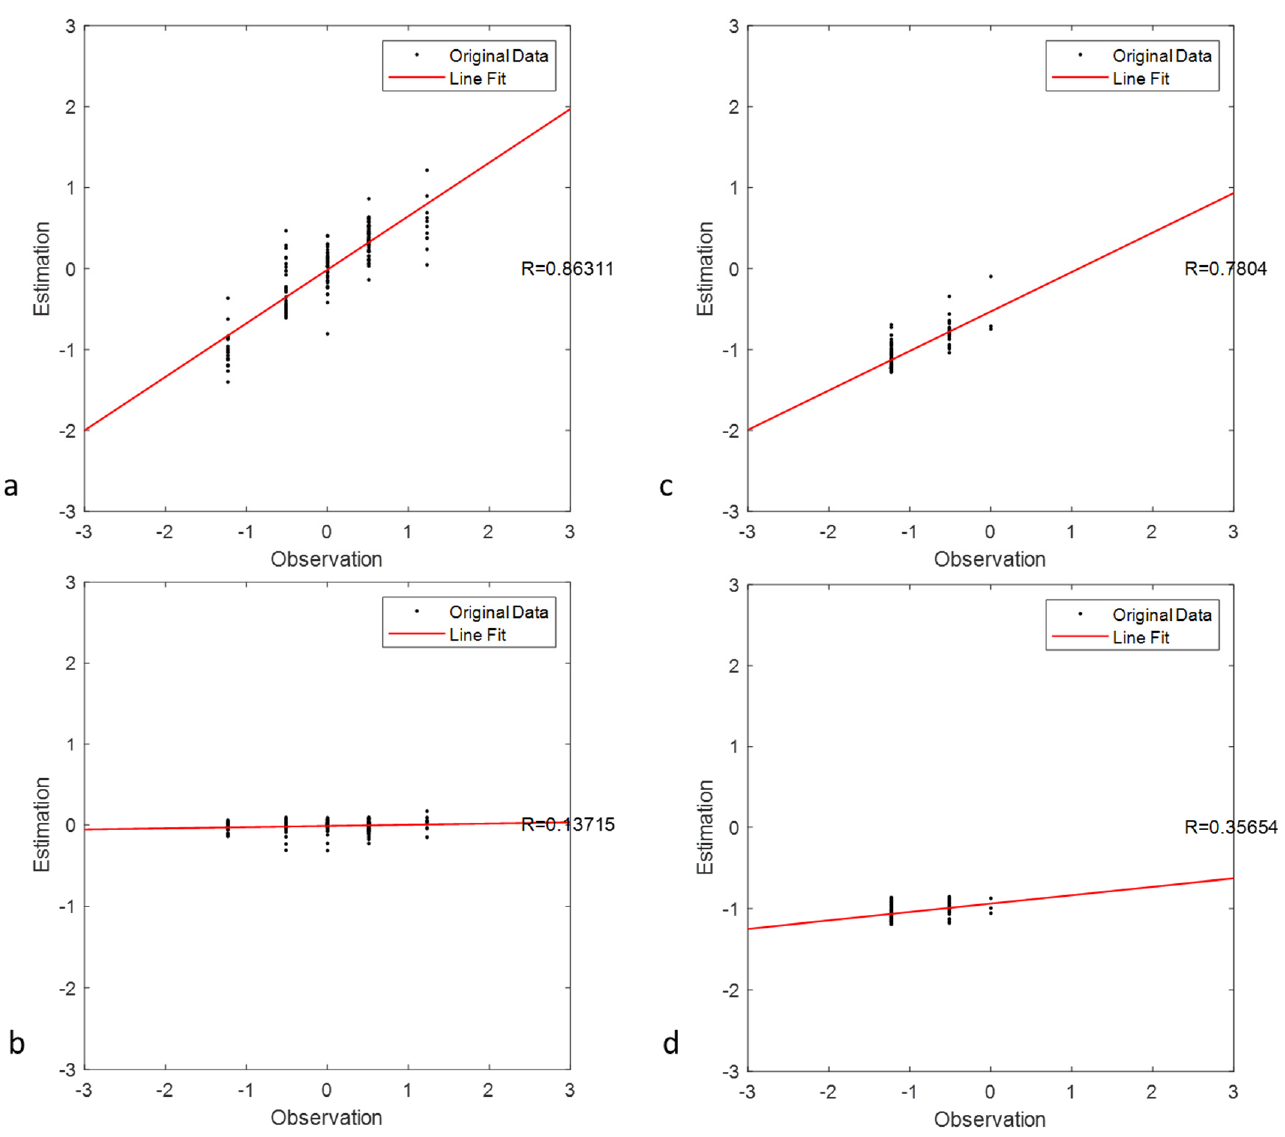
Figure 4. Estimation and observation plots of spatial ( a , c ) and nonspatial ( b , d ) downscaling of SPI 6 in June ( a , b ) and December ( c , d ) 2019.